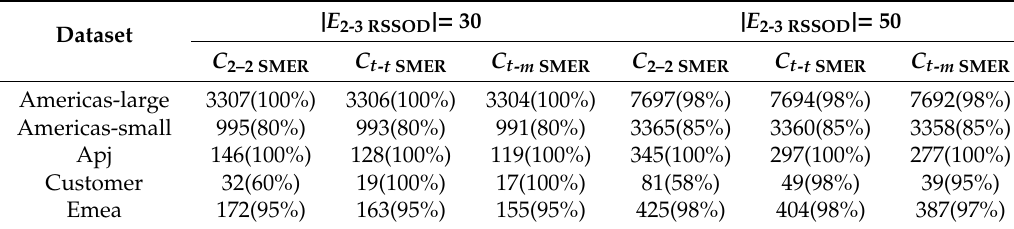
Table 8. Results of SMER constructed from 2–3 RSSOD.